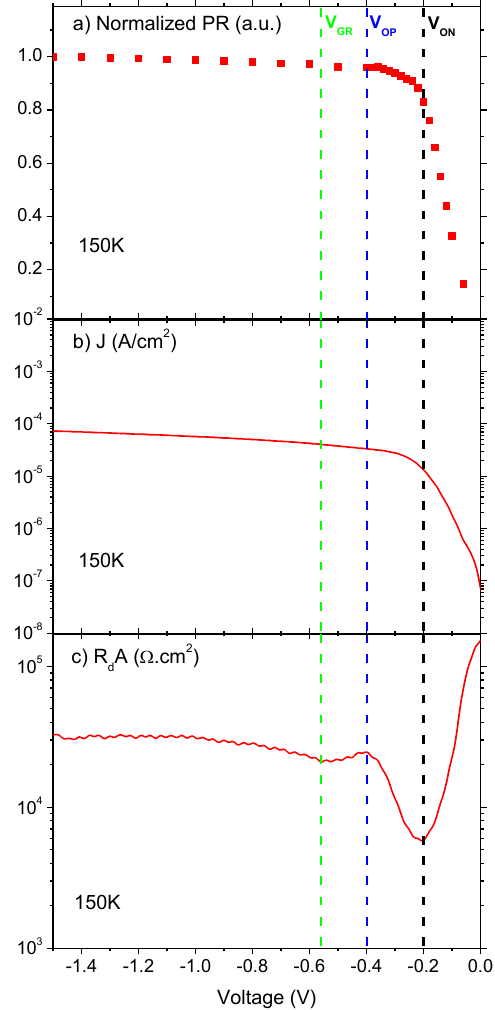
Figure 14. Stacking of the experimental ( a ) normalized photoresponse, ( b ) dark current density, ( c ) Differential Resistance Area product (RdA )product as a function of the voltage at 150 K for the Ga-free T2SL MWIR nBn photodetector.